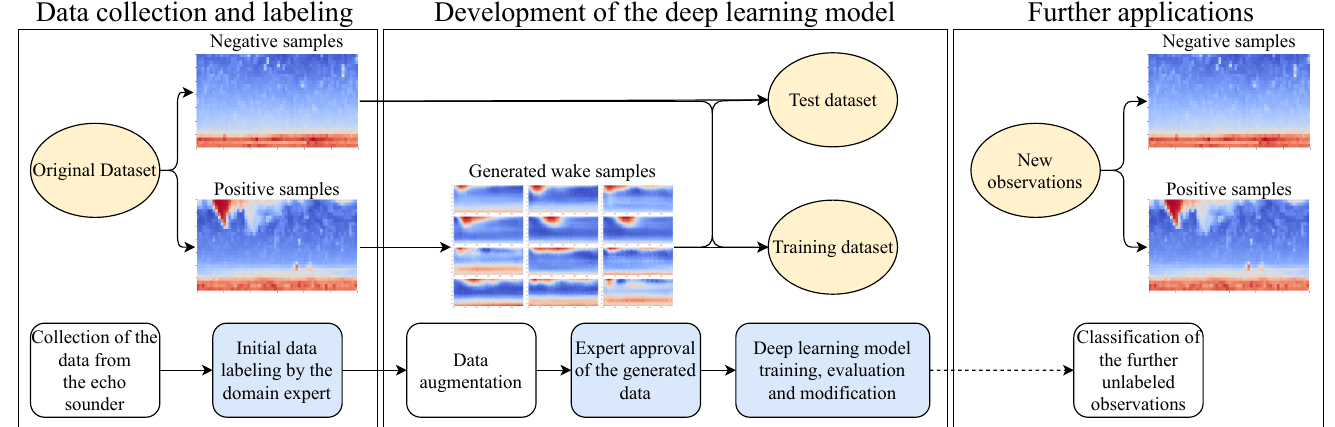
Figure 1. The framework pictured as a pipeline, showing all major steps from data collection to the final model evaluation. Potential further applications are also included in the diagram. Steps shaded in blue indicate the involvement of the domain